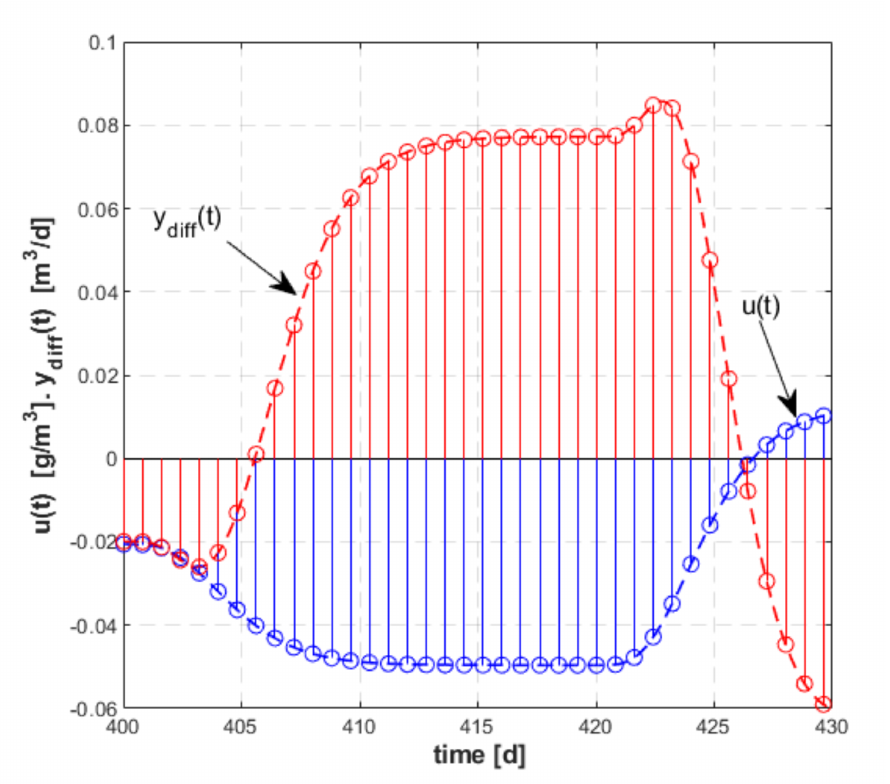
( t ) signals with the T s sampling period (blue and red dashed line, Figure 12. The u ( t ) and y diff respectively) and the impulses from these signals extracted with the T s1 sampling period.